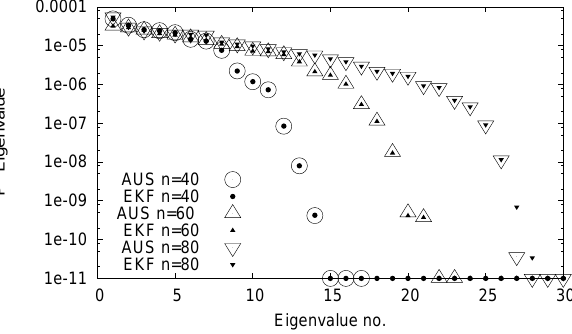
Fig. 2. Rank of the analysis error covariance matrix P a in the EKF algorithm. For n = 40 , 60 , 80, the dimension of the unstable and neutral space is 14 , 20 , 26, respectively. σ 0 = 0 . 01.